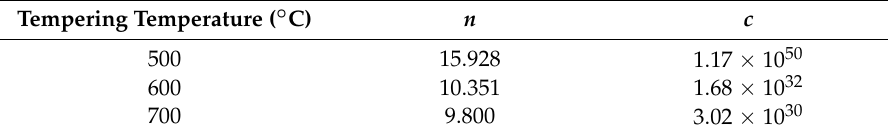
Table 6. Material constants at tempering temperatures 500 ◦ C, 600 ◦ C, and 700 ◦